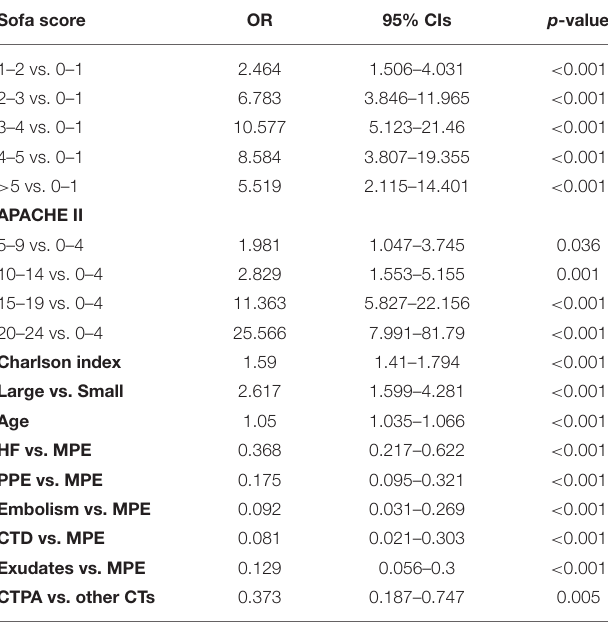
TABLE 3 | Univariate predictors of mortality at 1 month. Sofa score